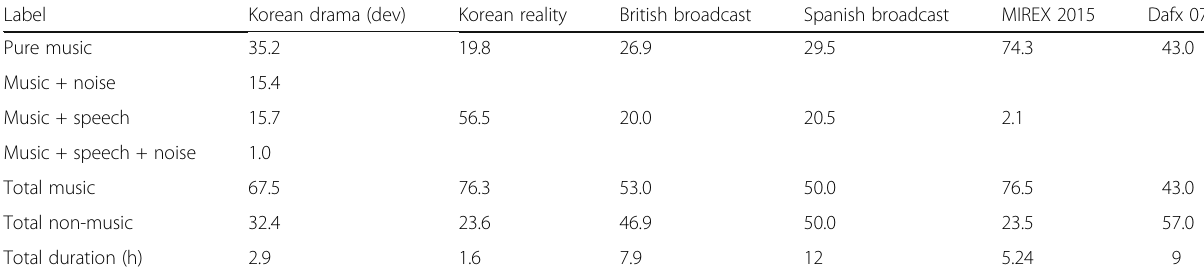
Table 2 Ratio (%) of music and non-music Label